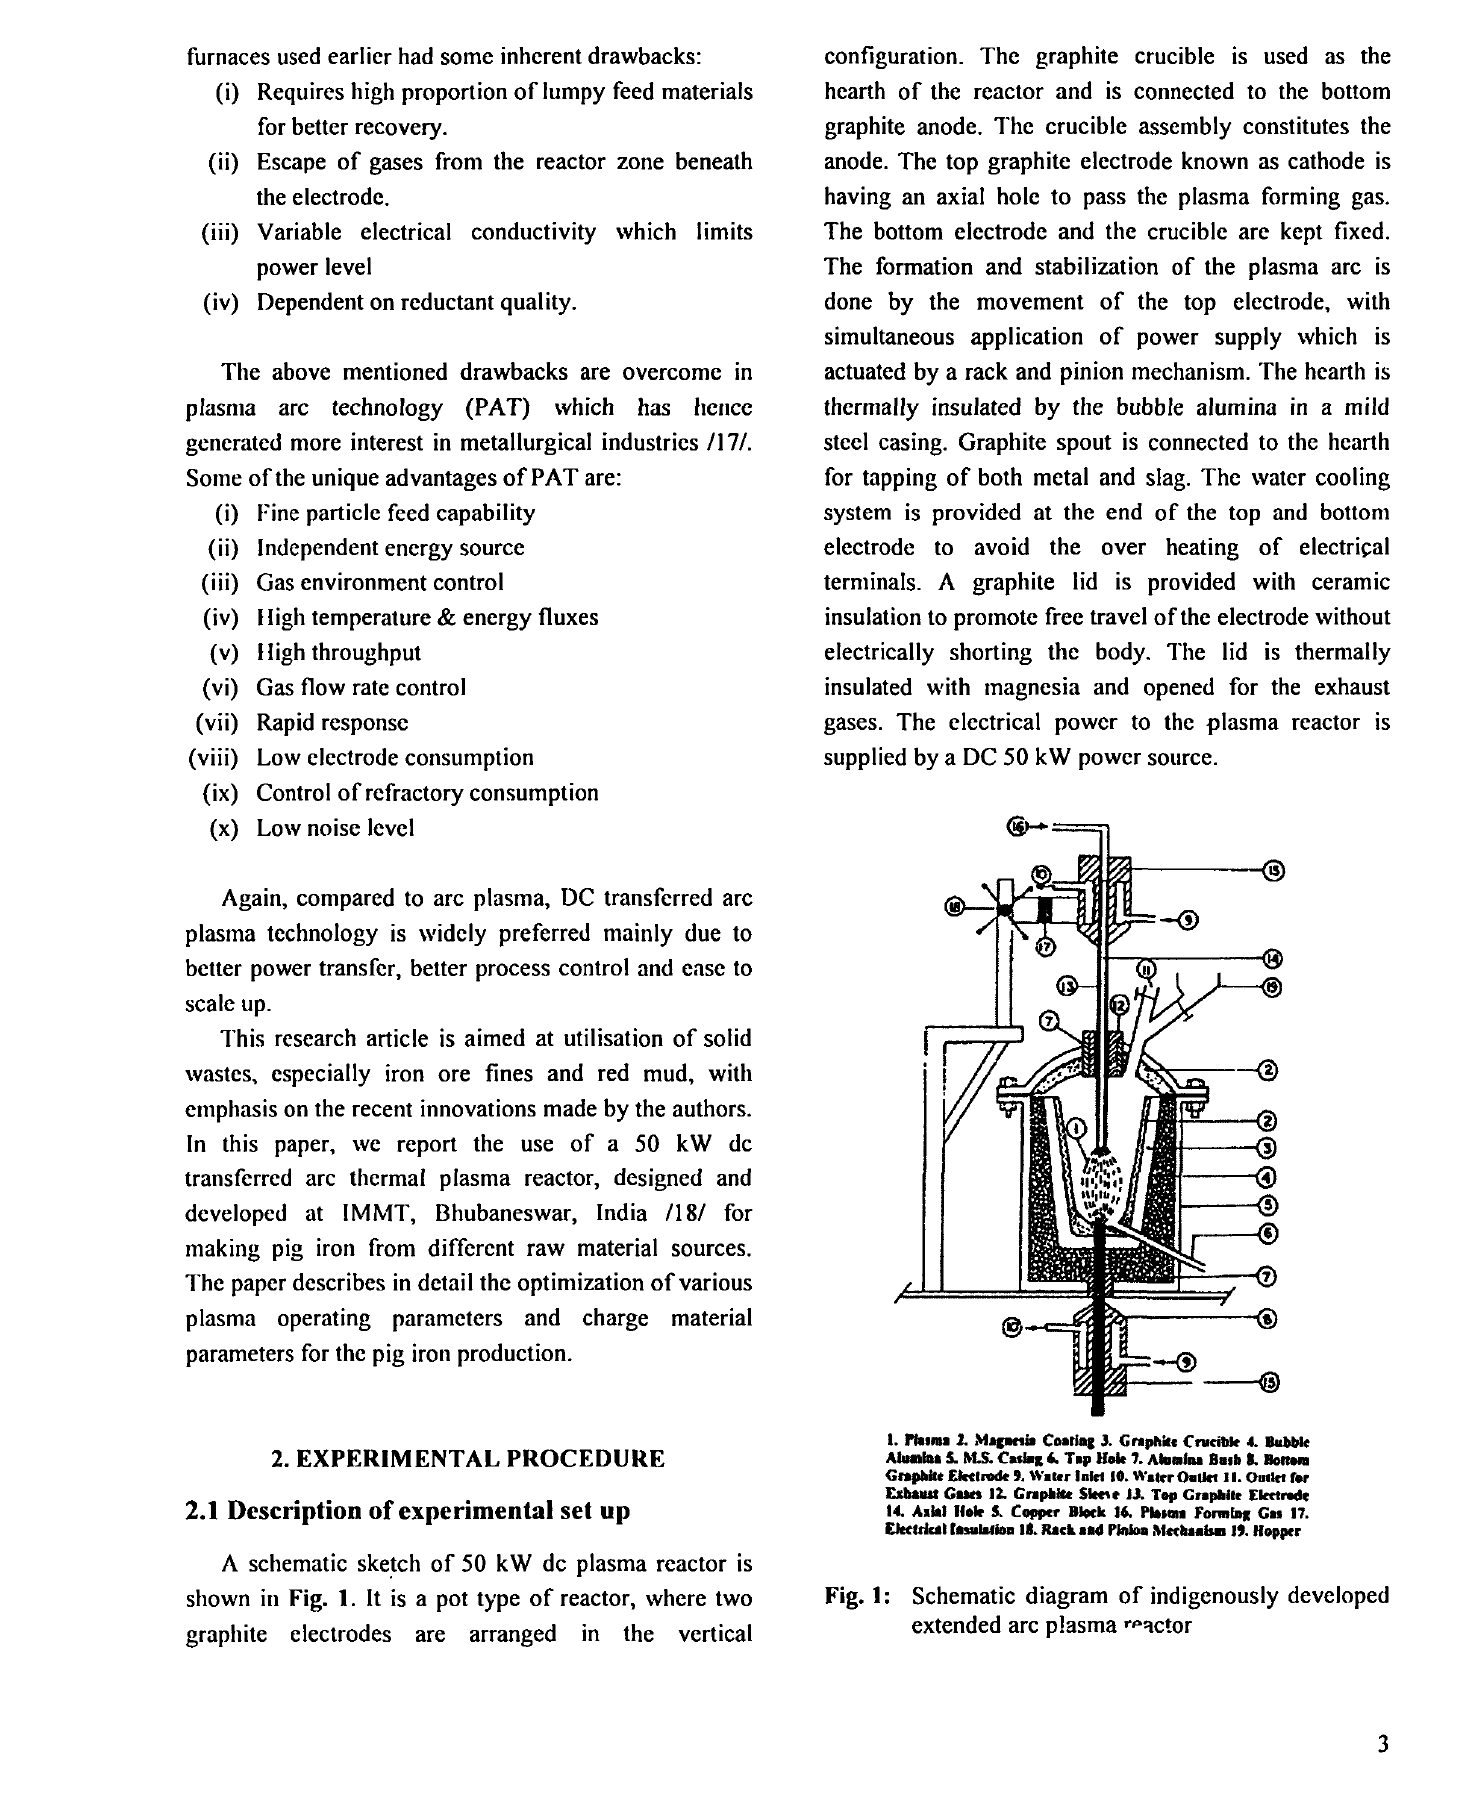
Fig. 1: Schematic diagram of indigenously developed extended arc